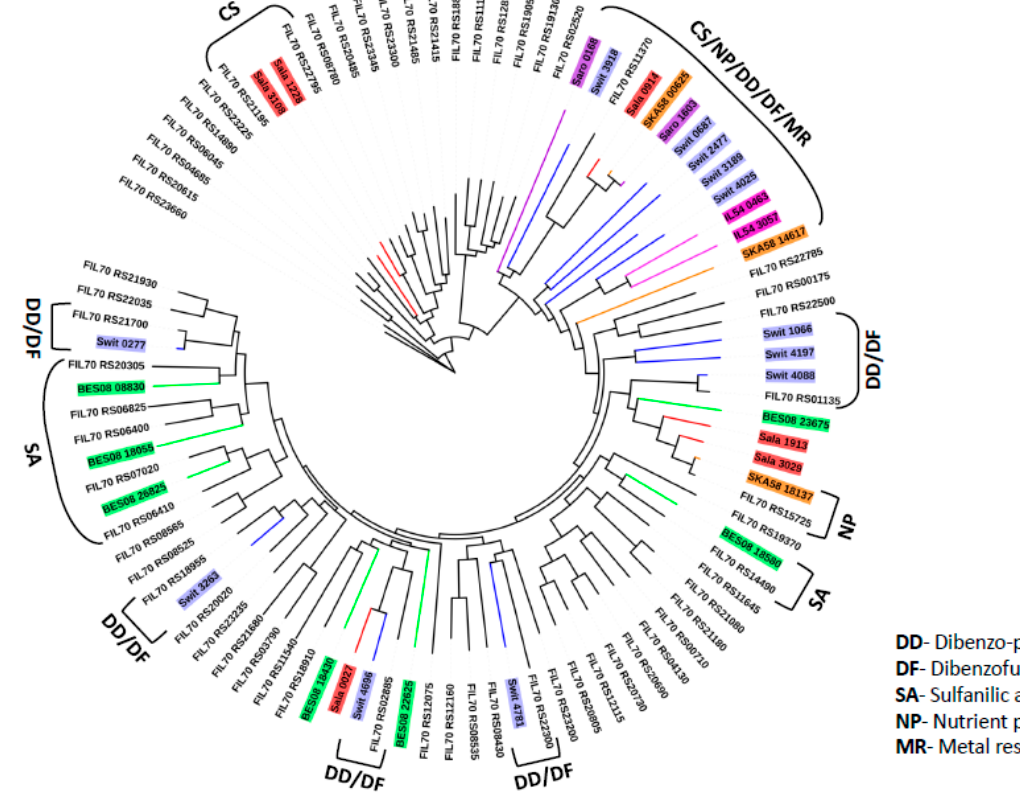
Figure 4. Expression pattern-based phylogenetic tree. Xenobiotic responsive TBDT sequences of Sphingomonas wittichii RW1 (blue), Sphingobium sp. ba1 (dark pink), Sphingopyxis alaskensis RB2256 (red), Sphingomonas sp. SKA58 (orange), and Novosphingobium aromaticivorans DSM 12444 (purple) are included along with 61 uncharacterized Sf TBDTs (black) while constructing the phylogenetic tree.